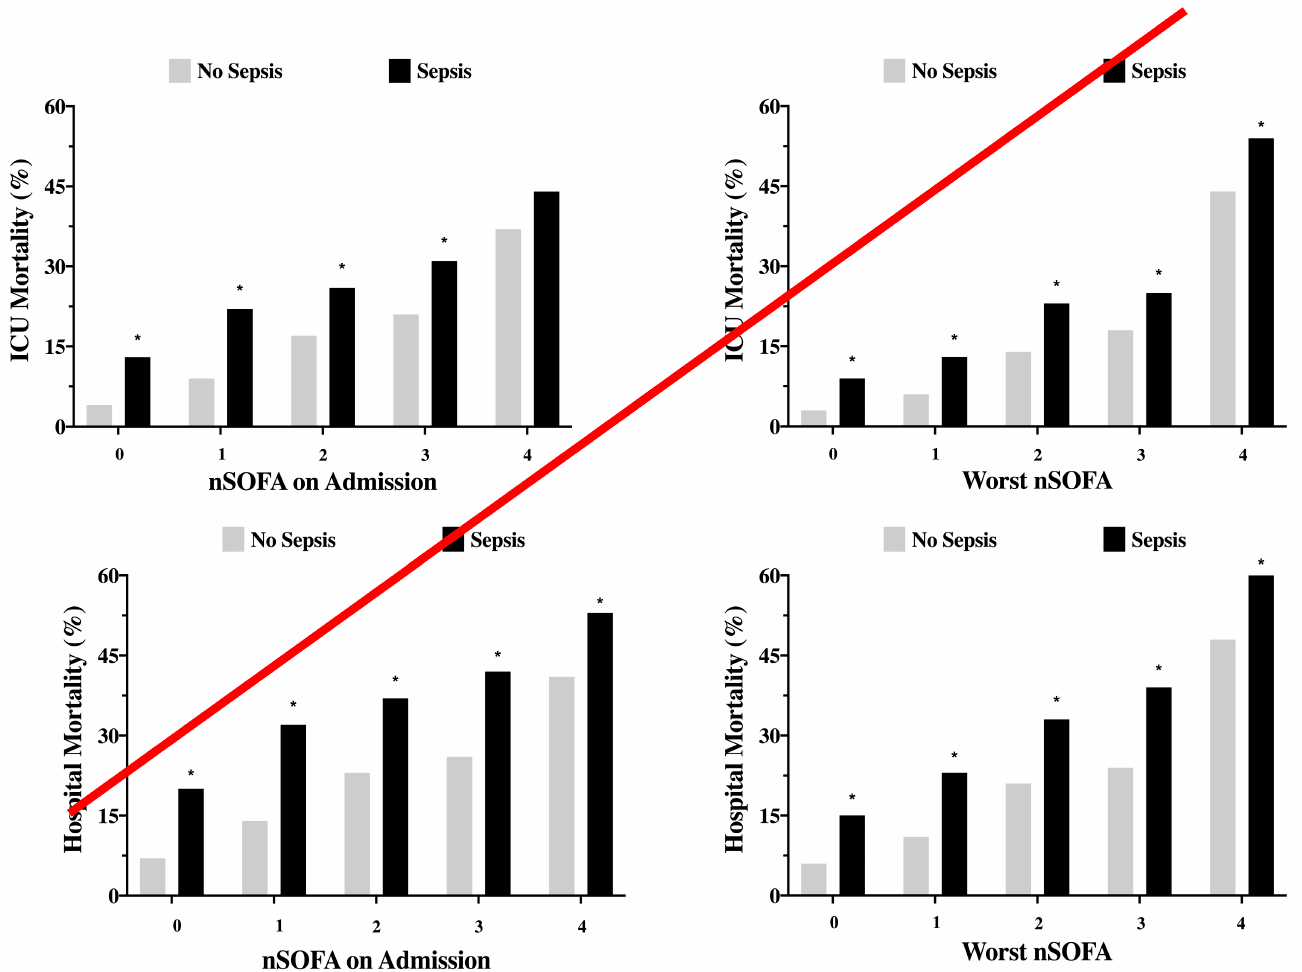
Figure 1. Intensive care unit (ICU) and hospital mortality in septic and non-septic patients, according to the neurological sequential organ failure assessment (nSOFA) score on admission and the worst nSOFA during the ICU stay. * p < 0.05. Hospital mortality was greater in septic patients with brain failure (318/604 (53%)) than in other patients (non-septic with brain failure 267/702 (38%); sepsis, no brain failure 275/1397 (20%); no sepsis, no brain failure 334/3878 (9%); p <